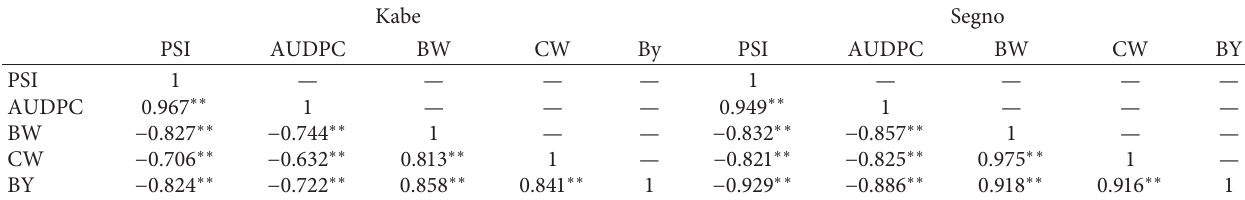
Table 7: Correlation coefficients of bulb yield, yield component, and disease parameters at Kabe and Segno during 2019 cropping season.